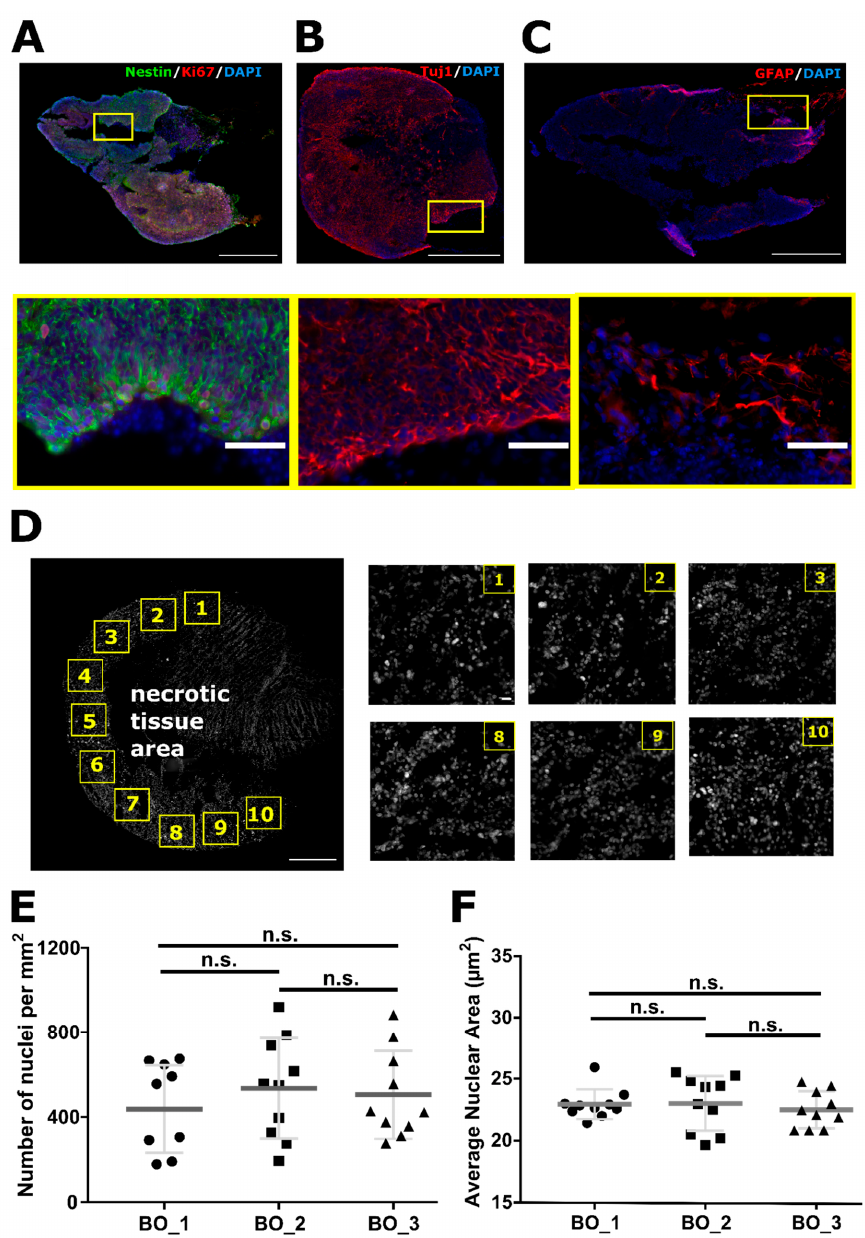
Figure 1. Characterization of cerebral organoid cellular composition and image analysis principle. Organoids are stained for different cellular markers to visualize their cellular structure at the growth stage used in this work: Two- to three-month-old organoids. Neural progenitors are labeled with ( A ) Nestin, together with proliferating cells Ki67; mature neurons with ( B ) Tuj 1; astrocytes with ( C ) GFAP marker. ( D ) For quantitative analysis, 10 cropped images along the edges of the organoid are taken to include as many different cell types as possible and to avoid necrotic tissue center. On the right side are representations of several crops used for the image analysis. To address inter- and intra-inhomogeneity within organoids, a number of nuclei and their areas were quantified for each of three control samples used. Despite, high inhomogeneity within organoids, there was no significant difference in the number of nuclei per mm 2 (0.6 mm 2 each cropped image) ( E ) nor their nuclear areas ( F ) between control organoids (data are represented by dot-plots where each dot represents mean value per one ROI (region of interest). n = 10 ROIs per organoid, total amount of DAPI + cells analyzed per group n > 4000). Scale bars 500 µ m, insert 50 µ m ( A ) and 500 µ m, insert 20 µ m ( D ). n.s.—non-significant (one-way ANOVA, followed by Tukey’s multiple comparisons test), BO—brain